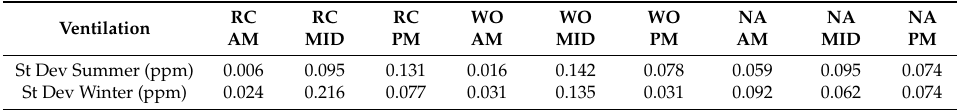
Table 2. Average standard deviation between the three sensors deployed for each of the ventilation settings, season, and time of day based on 10-s averages: RC (recirculate), WO (window open), NA (new air).